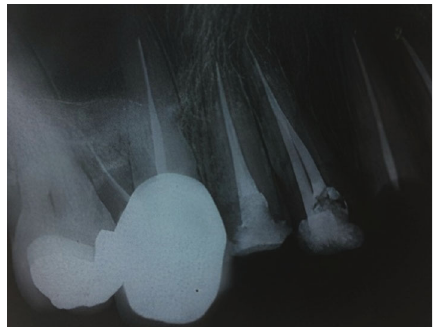
Figure 4: Periapical radiographic view of patient ’ s